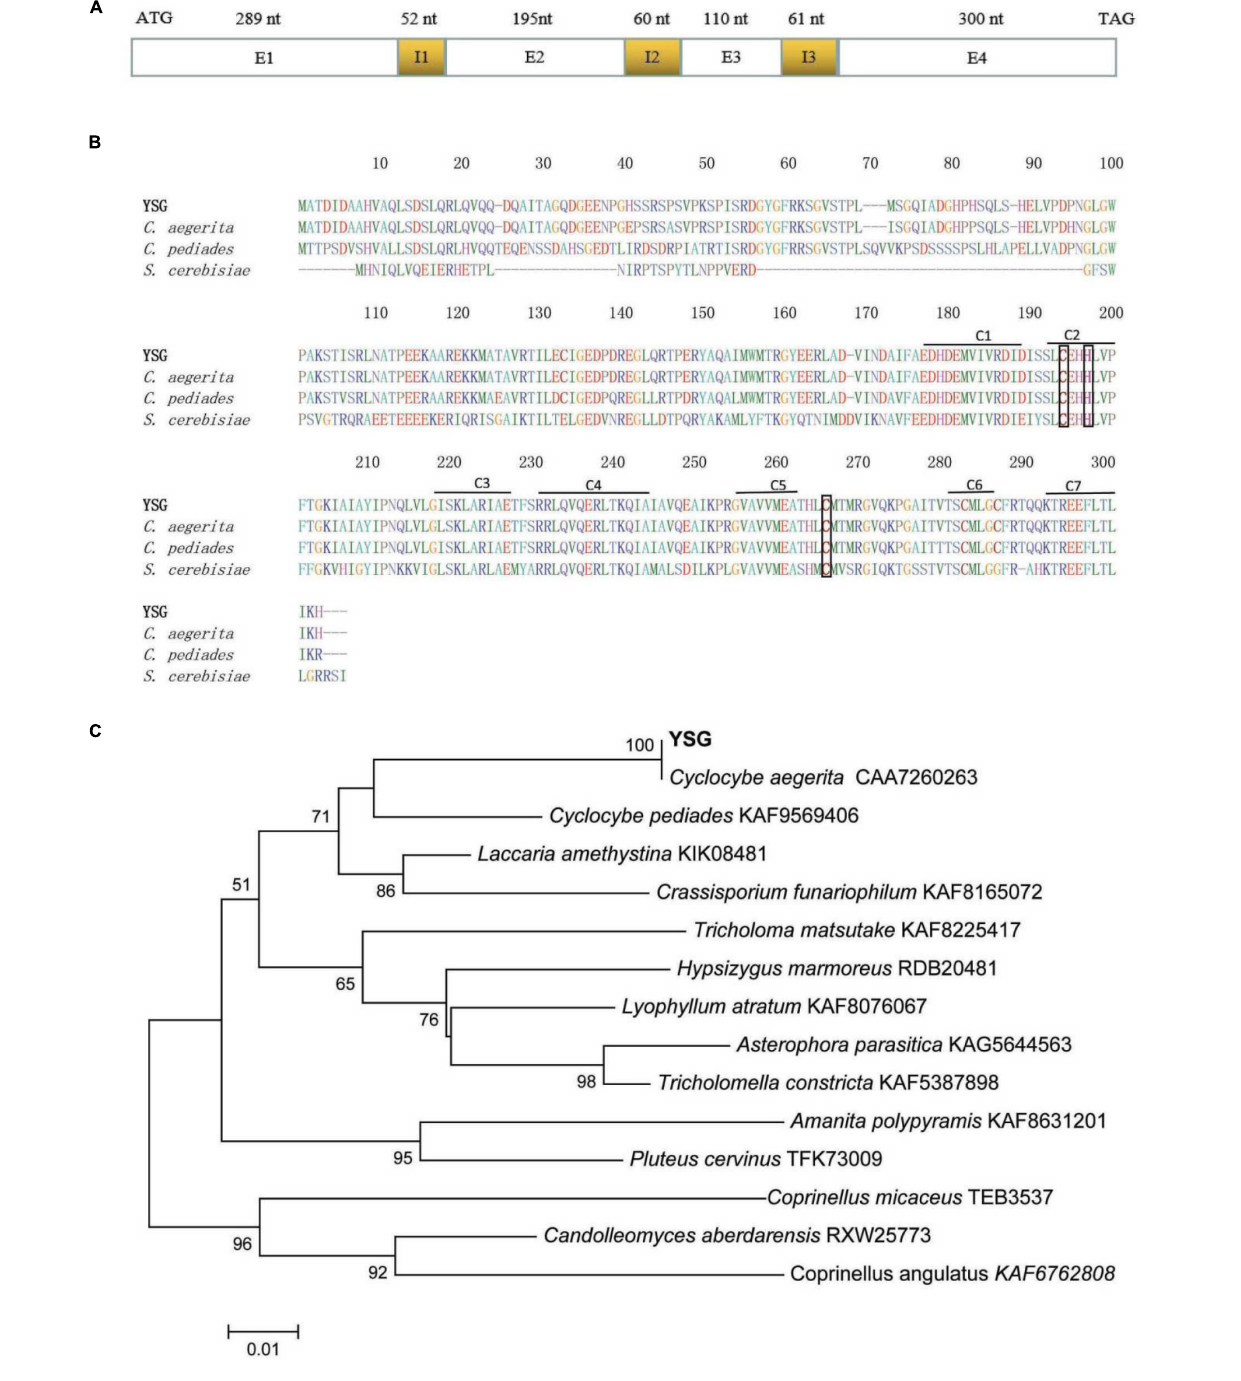
Frontiers in Microbiology |